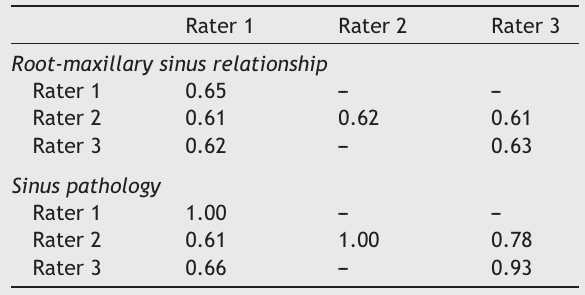
Kappa values for inter- and intra-rater